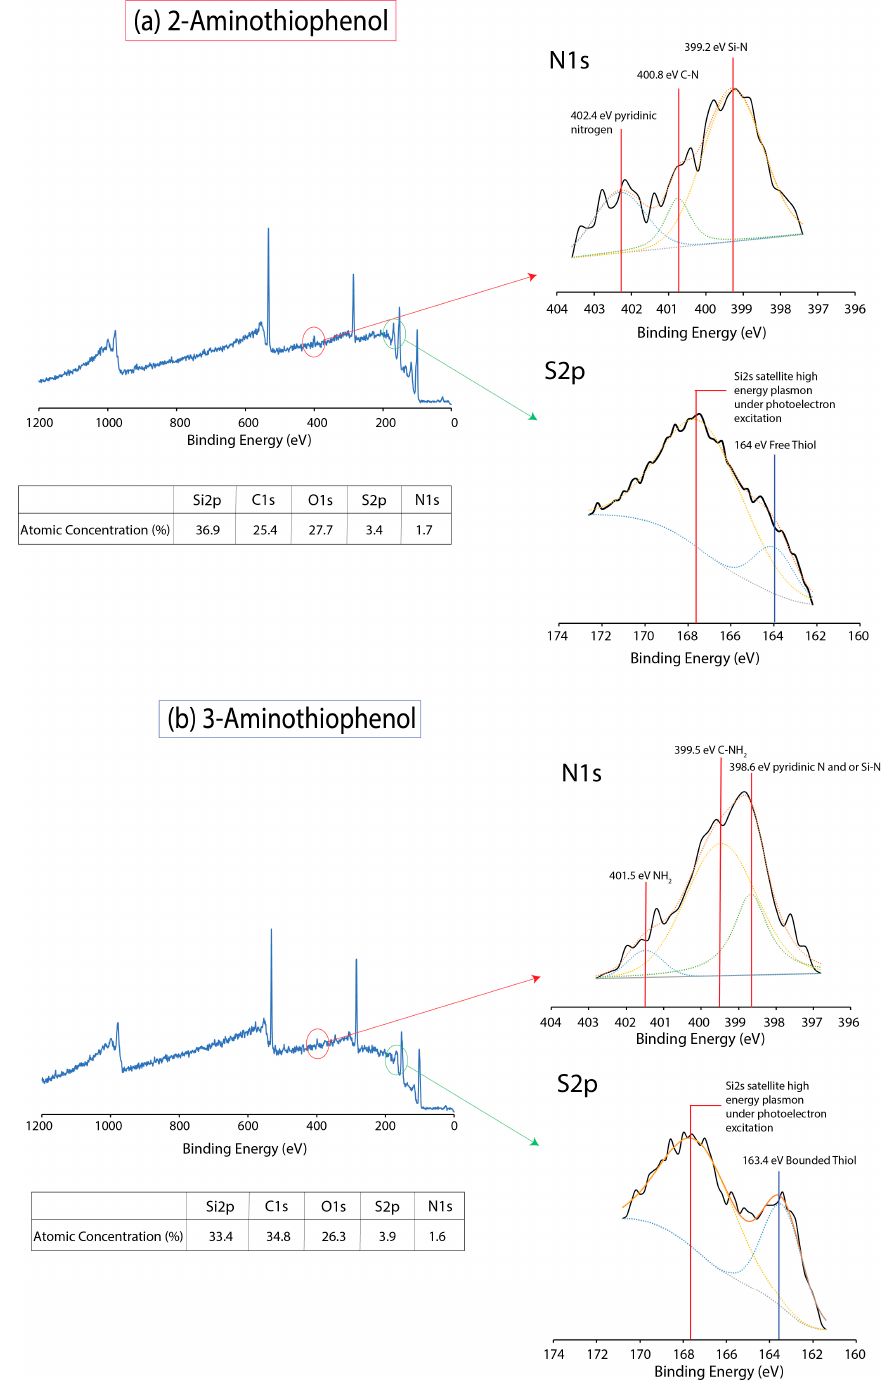
2 Figure 4. XPS survey spectrum for ( a ) 2-aminothiophenol and ( b ) 3-aminothiophenol after thermal grafting on silicon (111) hydride surfaces. Their respective N1s and S2p are shown as insets on the